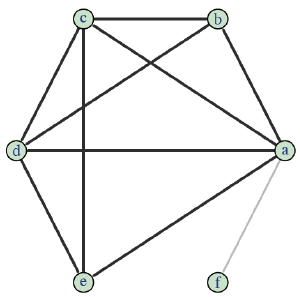
Figure A2. An example of a clique-based community in a network with two largest cliques of size